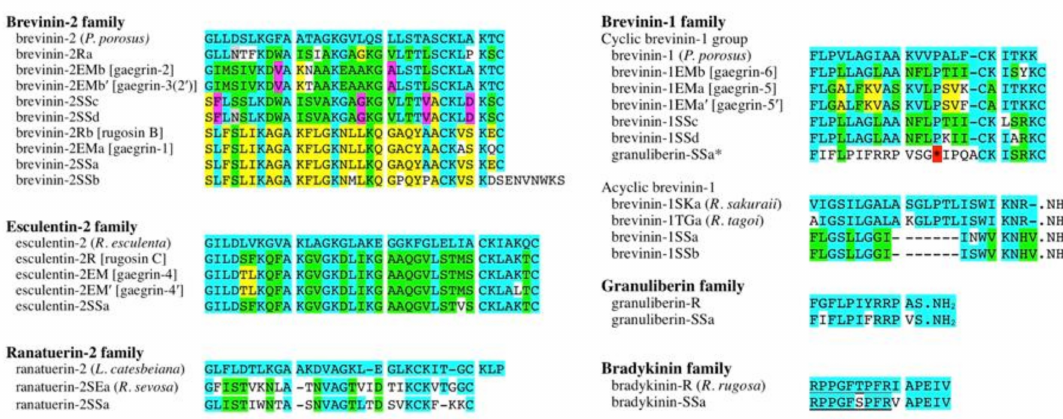
Figure 2. A comparison and schematic alignment of amino acid sequences of the brevinin-2, esculentin-2, ranaturerin-2, brevinin-1, granuliberin, andbradykininpeptidesdeducedfrom G.susurra AMPprecursor homolog cDNAs. Residues conserved among the Glandirana peptides and orthologs from other species are marked by the same color. The reference sequences of each peptide family (mainly the originally isolated ones) are at very upper lines. Gaps (-) were introduced to maximize the sequence identities. The asterisk (*) indicates a stop codon in the granuliberin-SSa, and the sequence following the asterisk shows high similarities to that of the cyclic brevinin-1SS peptides. Bradykinin sequences are underlined. Species names and the former peptide names are shown in parentheses and square blankets, respectively. In the peptide names, R, EM, and SS mean that the peptides were derived from G. rugosa , G. emeljanove, and G. susurra ,